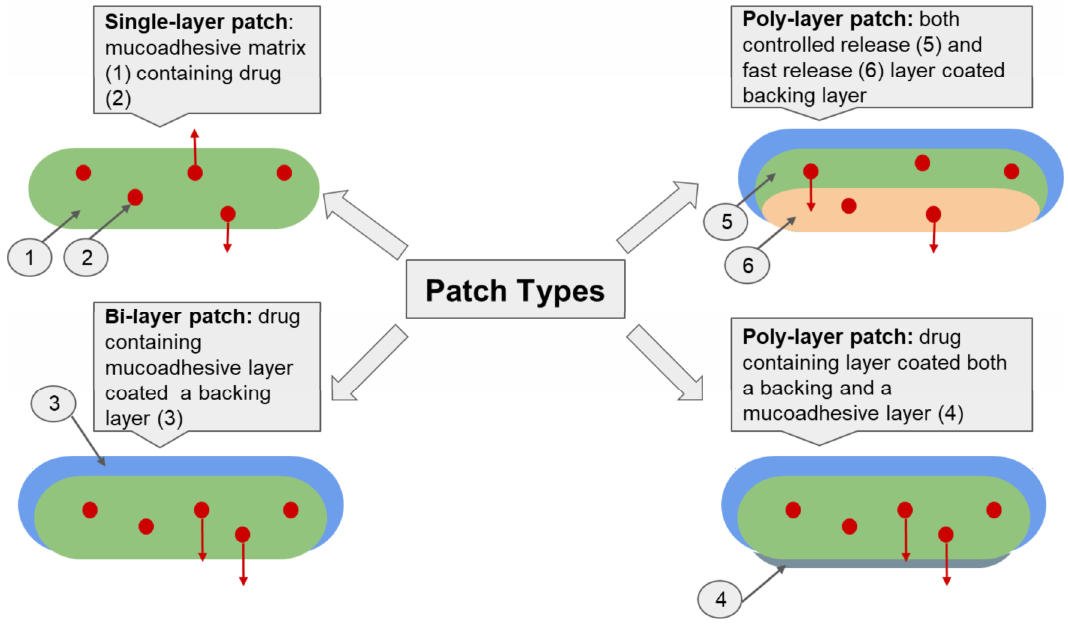
Figure 4. Illustration of various patch types.